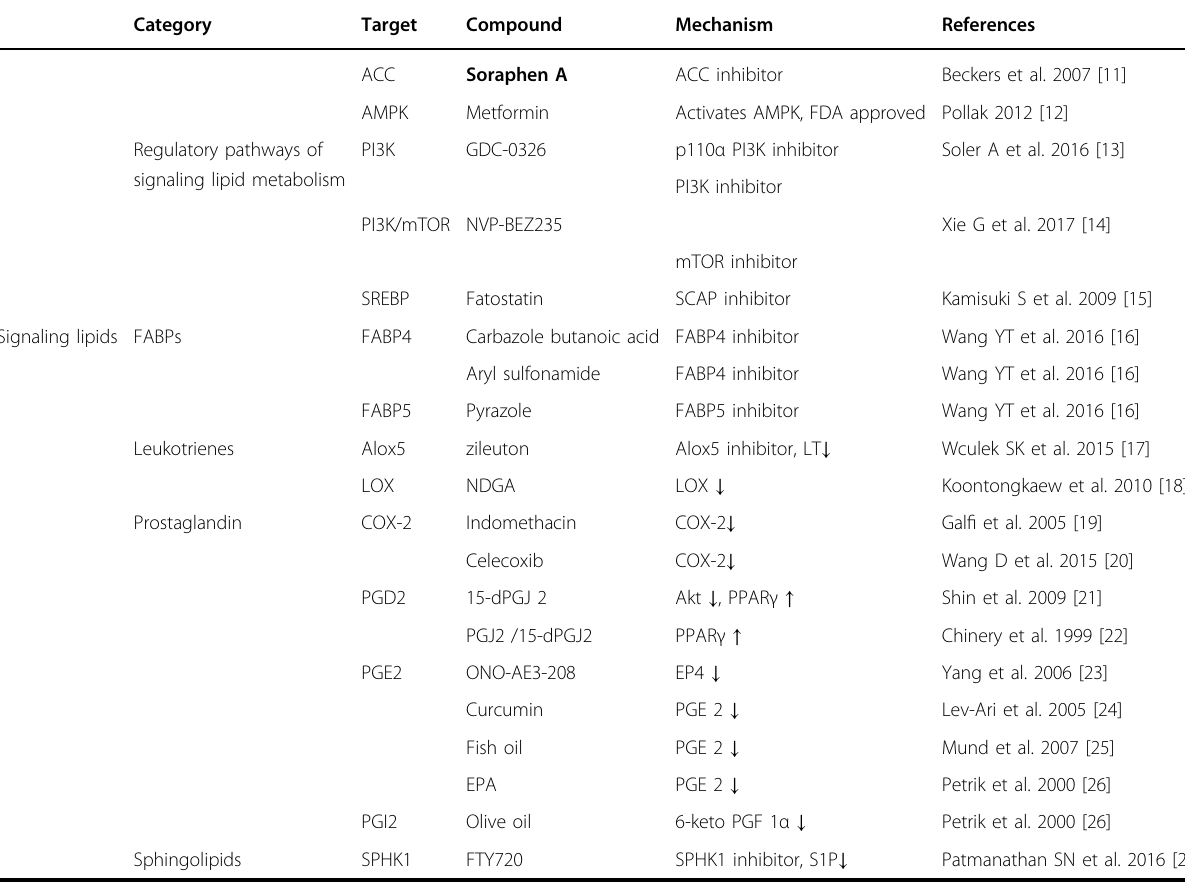
Table 1 Pharmacological tools to manipulate oncogenic regulatory pathways and lipid mediators associated with cancer